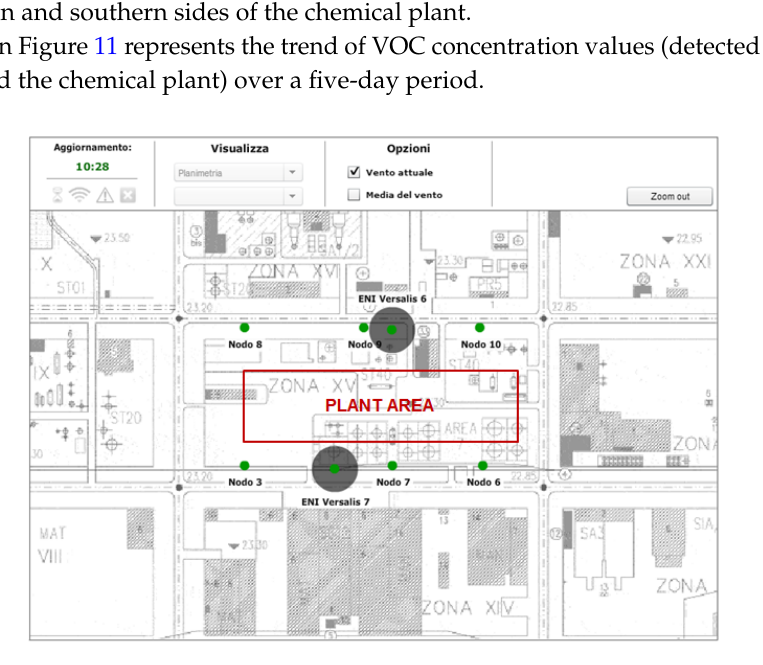
( a ) (b) Figure 11. VOC readouts from ( a ) northern side (Sink Node ENI 6) and ( b ) southern side (Sink Node ENI 7) with related wind direction (light green line) on Mantova installation.